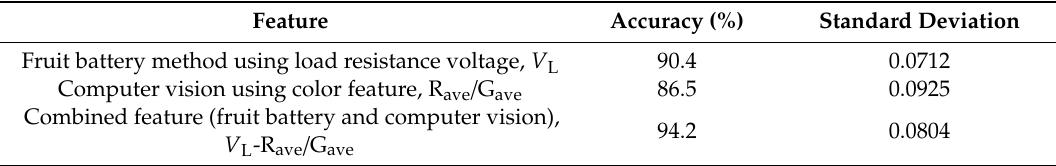
Table 7. Maximum accuracy score and standard deviation of each feature.